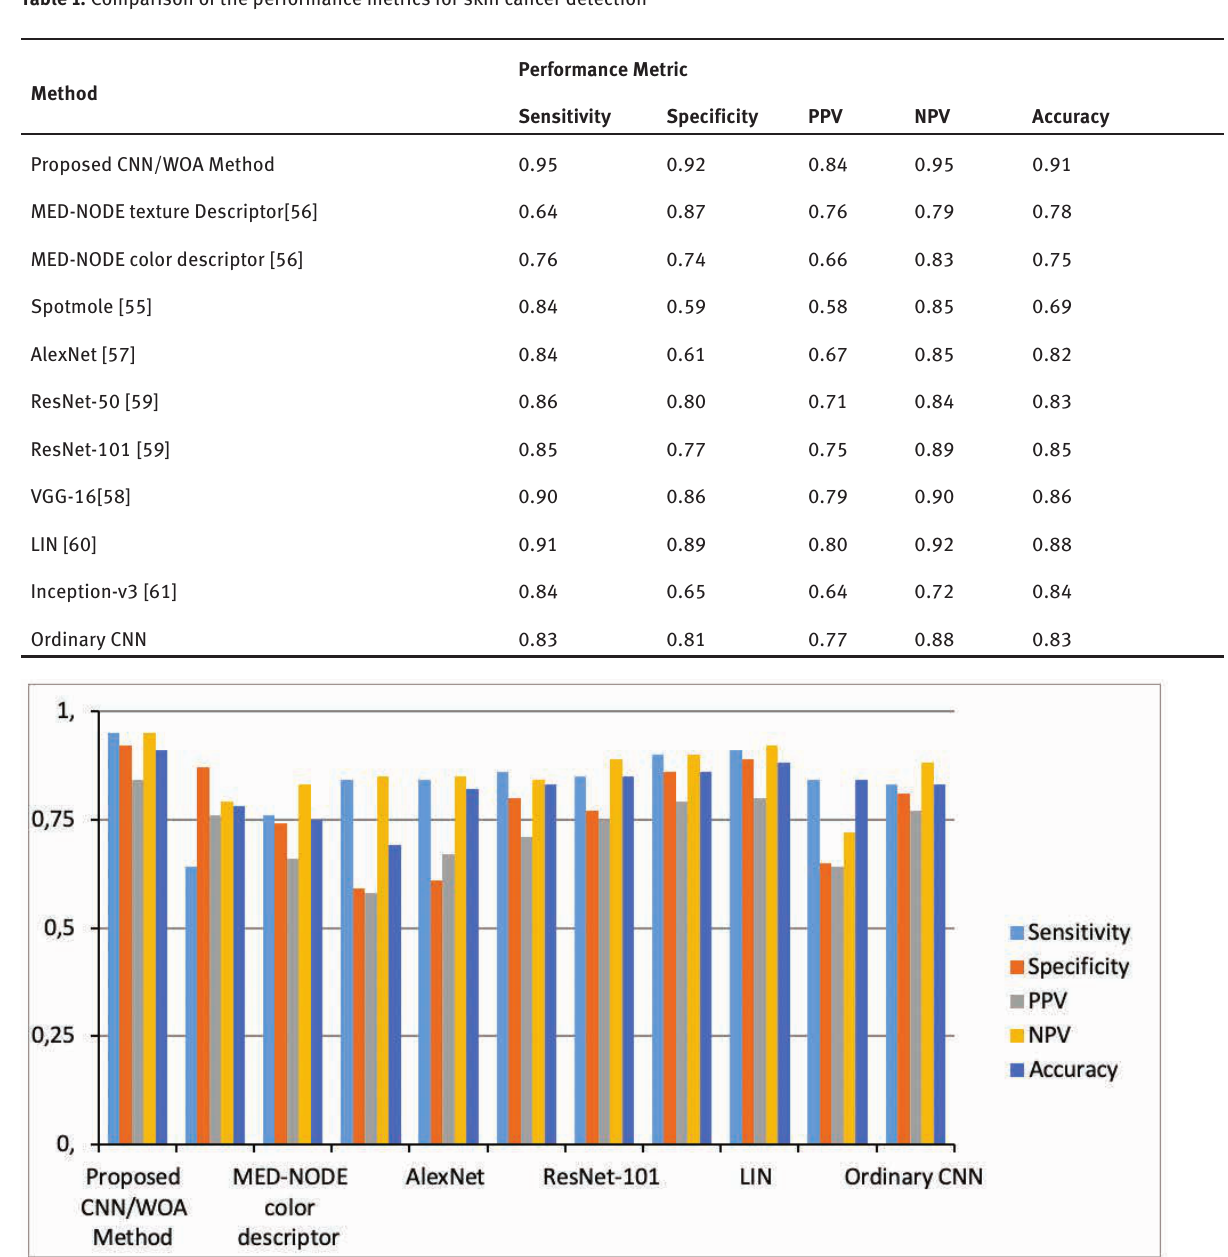
Table 1: Comparison of the performance metrics for skin cancer detection